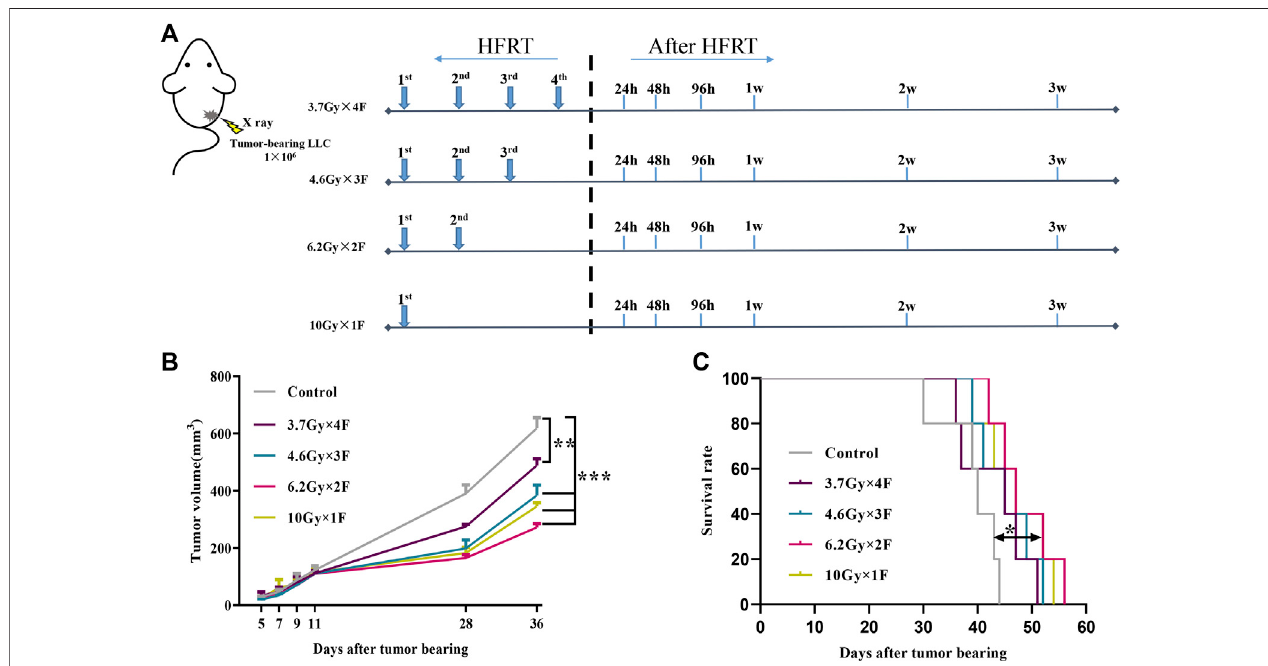
FIGURE 1 | Study design, tumor growth, and survival curves. (A) Study design. LLC cells were implanted subcutaneously into the right leg of C57BL/6 mouse on day 0. The mouse received 3.7 Gy × 4 F, 4.6 Gy × 3 F, 6.2 Gy × 2 F, and 10 Gy × 1F radiotherapy. Then collected tail-tip blood samples at different timepoints after radiotherapy. (B) Growth curve oftumor inmouse. Thetumor volume wassigni fi cantlyreducedindifferentfractionation radiotherapies. (C) Survivalcurve ofmouse. The survival time of 6.2 Gy × 2 F fractionation was signi fi cantly prolonged. * p ＜ 0.05, ** p ＜ 0.01, *** p ＜ 0.001, compared with the control